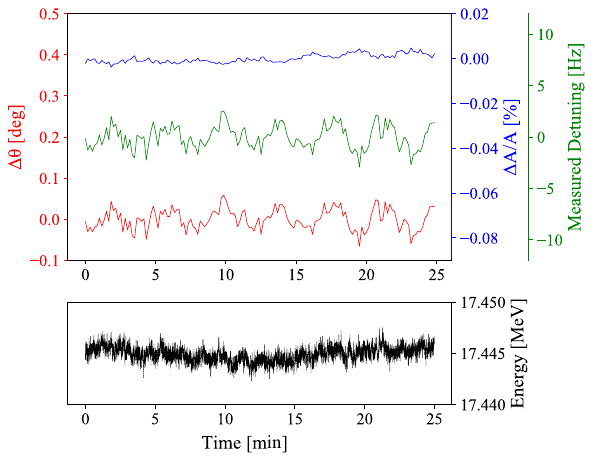
FIG. 6. Long term pulse-to-pulse amplitude (blue), phase (red) and detuning (green) during the flat-top of the rf pulse on ML2 at 10.5 MV. An obvious beam energy dirft (black) was